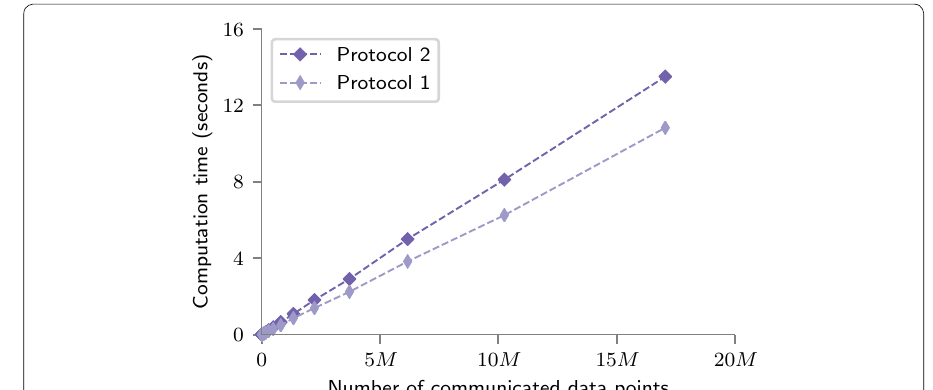
Fig. 27 Evaluation of messaging protocols. Protocol 1 is used in this work